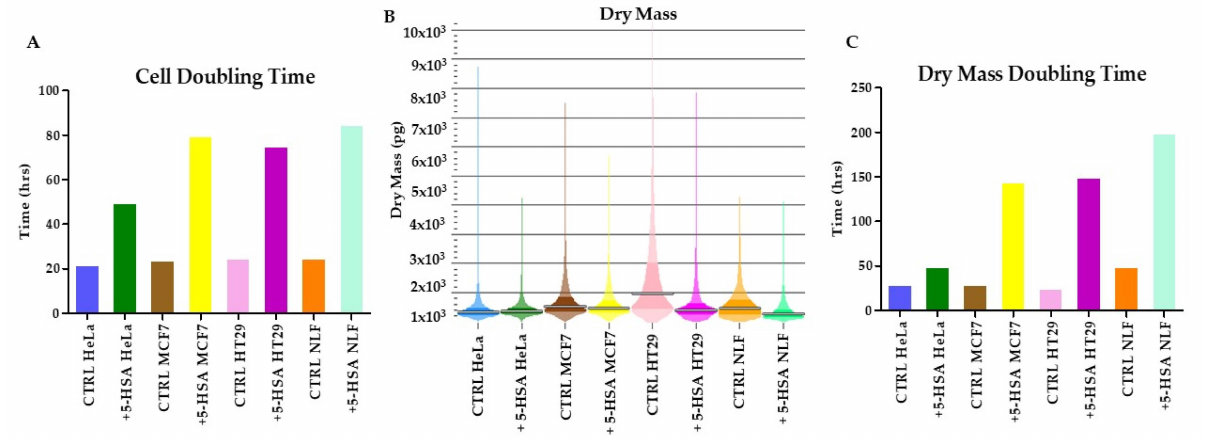
Figure 3. Effect of 50 µ M 5-HSA treatment on cell proliferation and morphology. ( A ) Histogram plot illustrating median cell doubling time. ( B ) Distribution of the cellular dry mass for HeLa, MCF7, HT29, and NLF cells, treated and control. ( C ) Histogram plot illustrating dry mass doubling time of cells, treated and control.